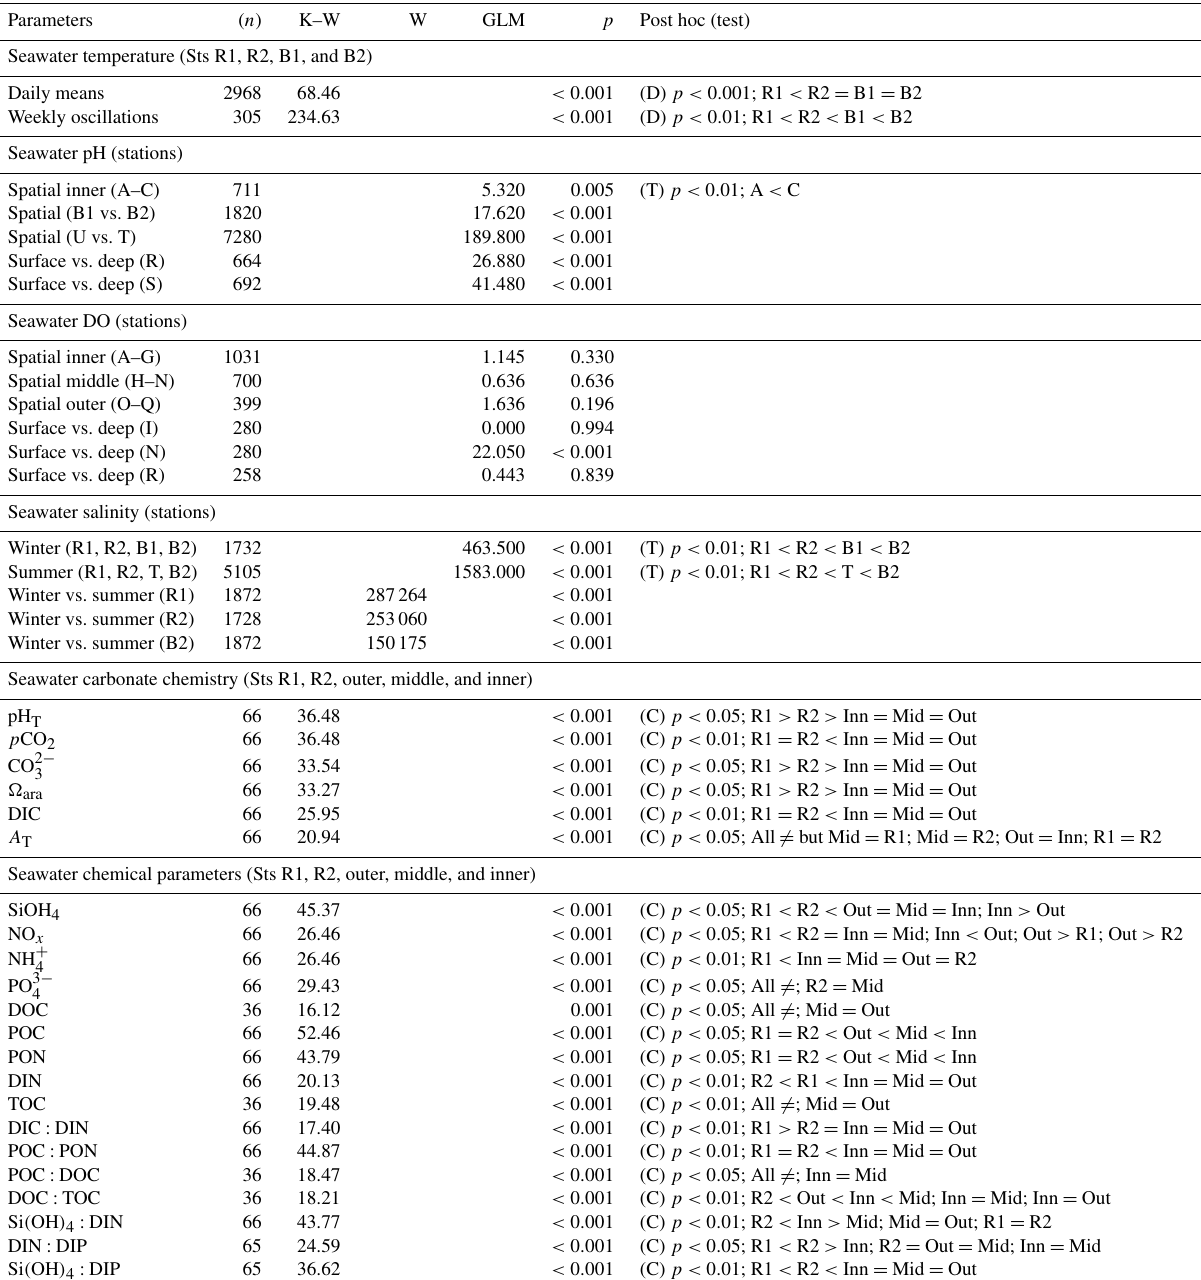
Table 1. Summary of the statistical analyses applied to the seawater physical and chemical parameters collected between 2016 and 2020 at the Bouraké lagoon (Sts B1, B2, A–R, outer, middle, and inner) and at reference reefs (Sts R1 and R2). Differences in temperature, salinity, and chemical parameters between the Bouraké lagoon and reference reefs and spatial and vertical differences in pH and DO inside the Bouraké lagoon. K–W: Kruskal–Wallis’s test; W: Wilcoxon test; GLM: general linear model; D: Dunn’s test; T: Tukey’s test; C: Conover’s